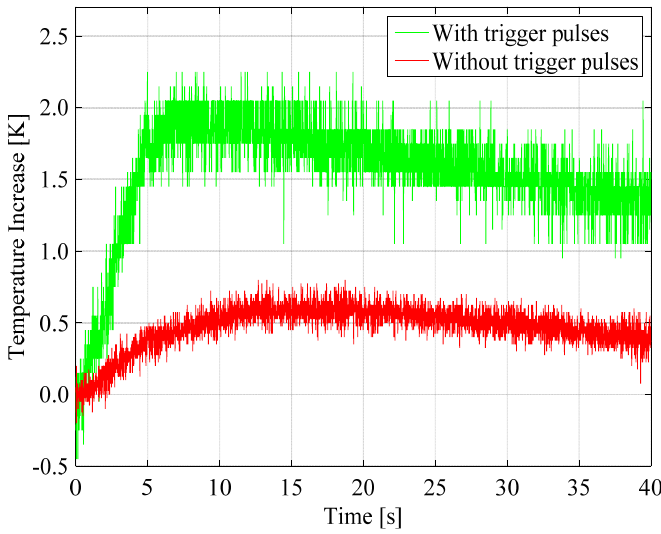
Figure 8. Temperature increases of a single measurement with a trigger HIFU sequence similar to that shown in Figure 1a and averaged over four measurements without trigger pulses at a lateral distance of 2.7 mm above the HIFU focus [31]. The instantaneous total acoustic powers of the trigger pulses and heating bursts were 900 and 13 W, respectively. The duration times of trigger pulses and heating bursts were 0.1 and 499.9 ms, respectively. There was no interval time for ultrasound imaging and the total duration time of HIFU exposure was 5 s.